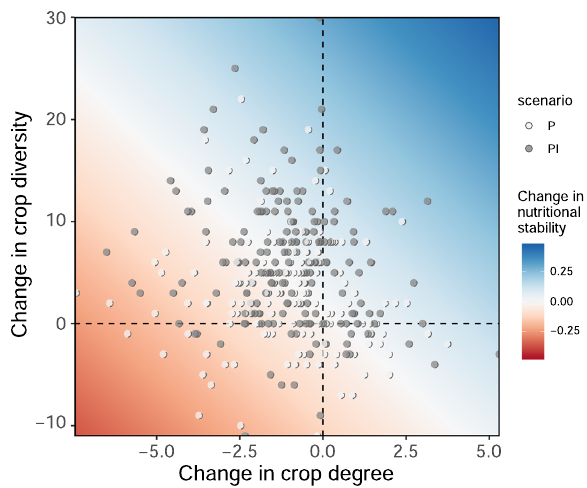
Fig. 5 Change in crop diversity, degree, and nutritional stability. Each point depicts the difference between a country ’ s last (2016) and fi rst annual record of crop diversity (i.e., number of crops) and crop degree (i.e., average number of nutrients connected to each crop) for production ( P ; white circles) and production plus imports (PI; gray circles). The response surface projects the expected change in nutritional stability as predicted by simple linear regression ( R N ~ diversity change + degree change; see Supplementary Table